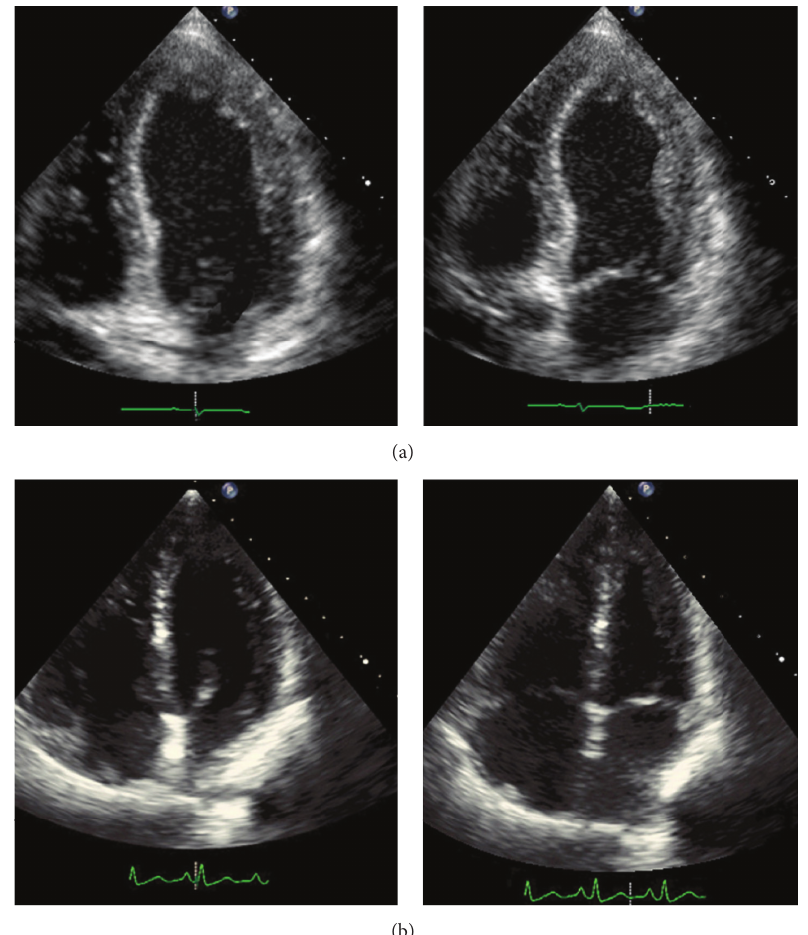
Figure 1: Echocardiogram images obtained during the hospitalization (a) and ten weeks later (b). An apical four-chamber view is shown at end diastole (left) and at end systole